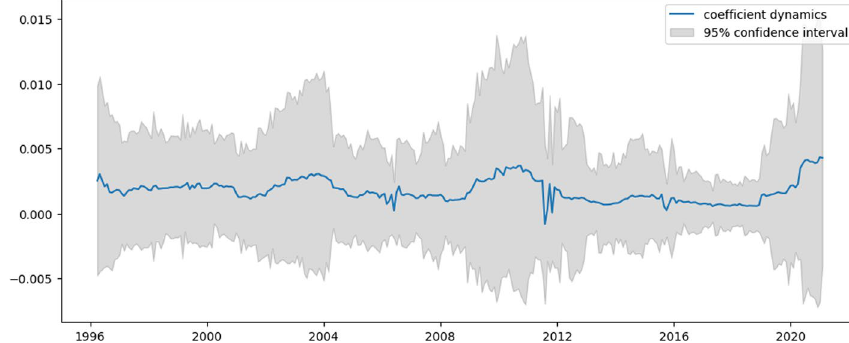
Fig. 2 Intercept dynamics for US e-trade